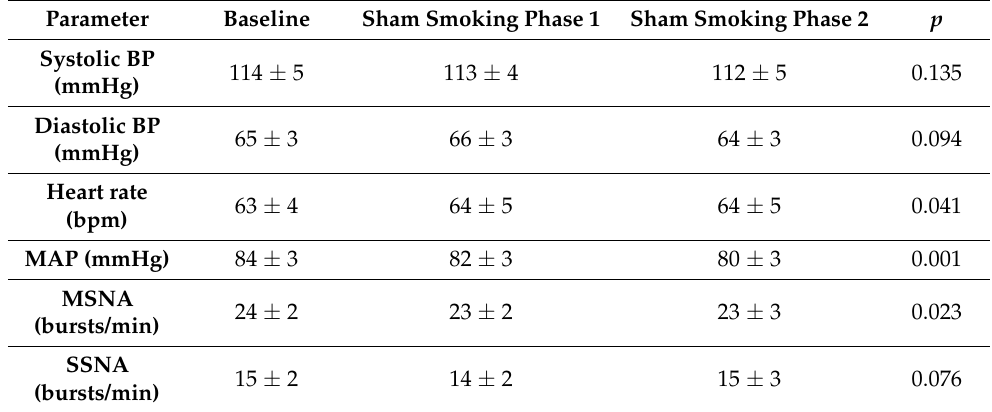
Table 2. Effects of sham smoking on hemodynamic parameters and on sympathetic